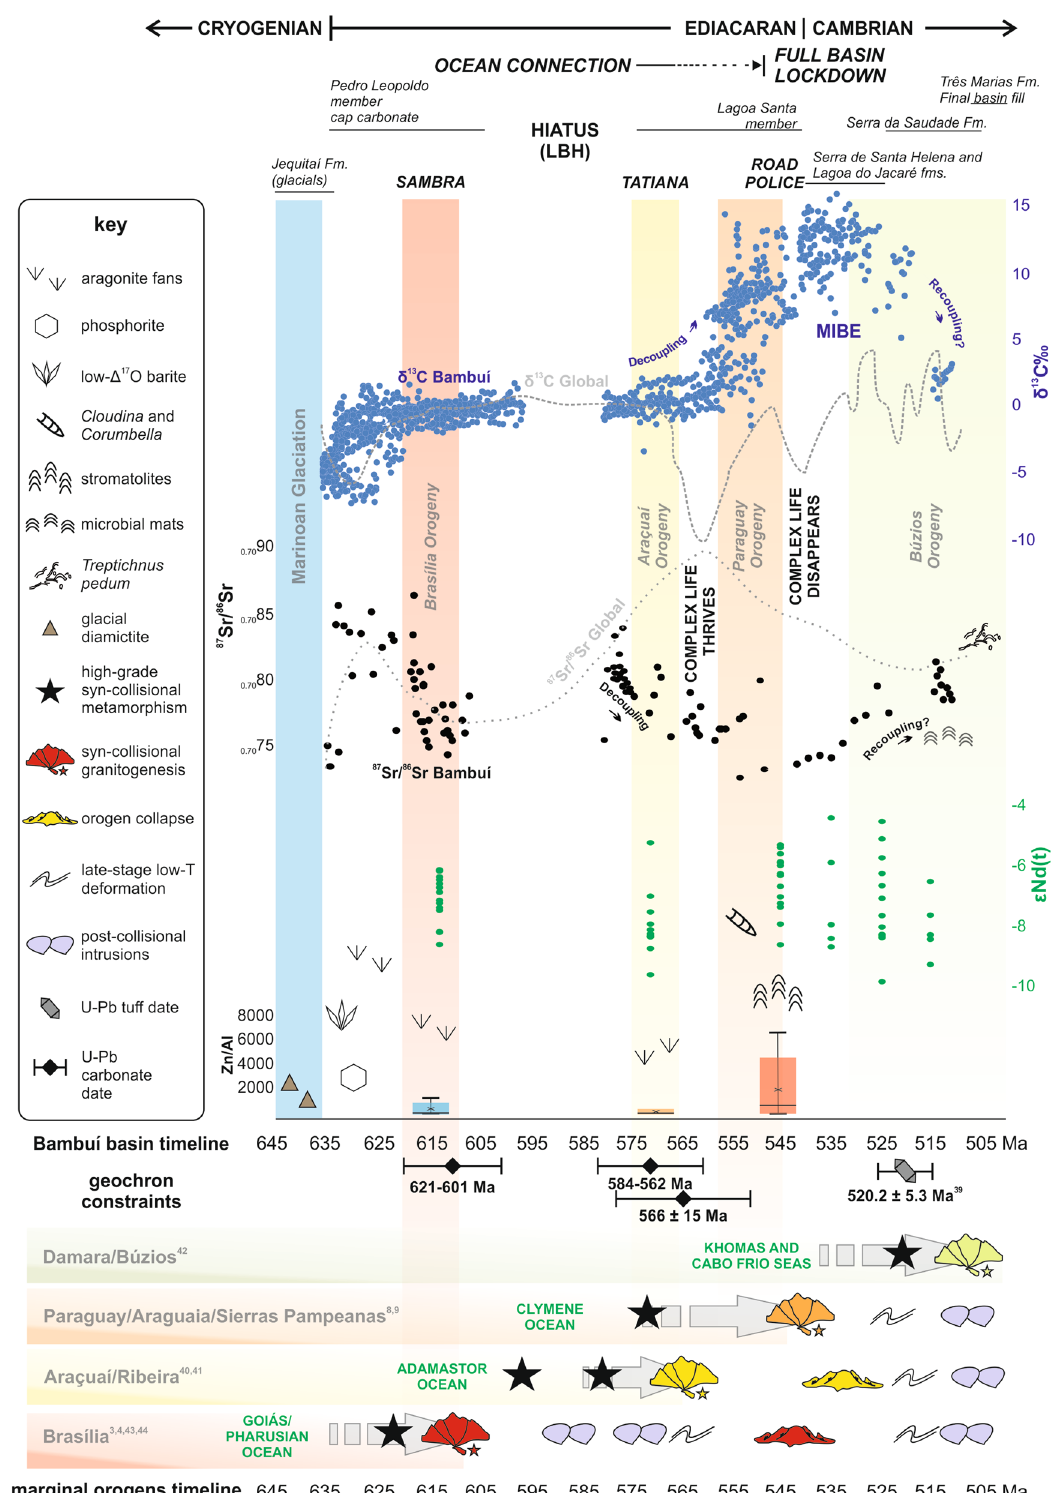
Figure 5. Timeline showing the integrated evolution of mountain belts and metazoan-bearing basins at the core of western Gondwana. The new data provided here is combined in a comprehensive compilation of C (blue dots) and Sr (black dots) isotope data from the literature, interpreted in the framework proposed here and compared to the global carbon and strontium isotope curves 36 . Literature-compiled Nd isotope data (in green, with poorer stratigraphic control than C and Sr data) is also presented for comparison. The amount of nutrient input in each evolutionary stage of the basin is represented by Box–Whisker plots of Zn/Al ratios, color-coded according to Fig. 4. Figure created using Microsoft Excel Professional Plus 2016 (http:// www. micro soft. com), Corel Draw Graphics Suite 2018 (http:// www. corel draw. com) and a Huion Kamvas GS1331B pen display (http:// www. huion.